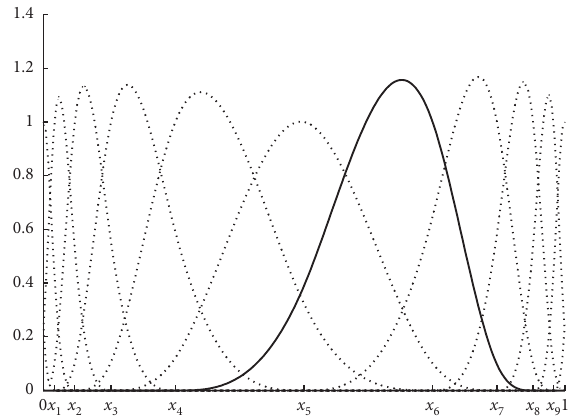
Figure 1: Basis function set B